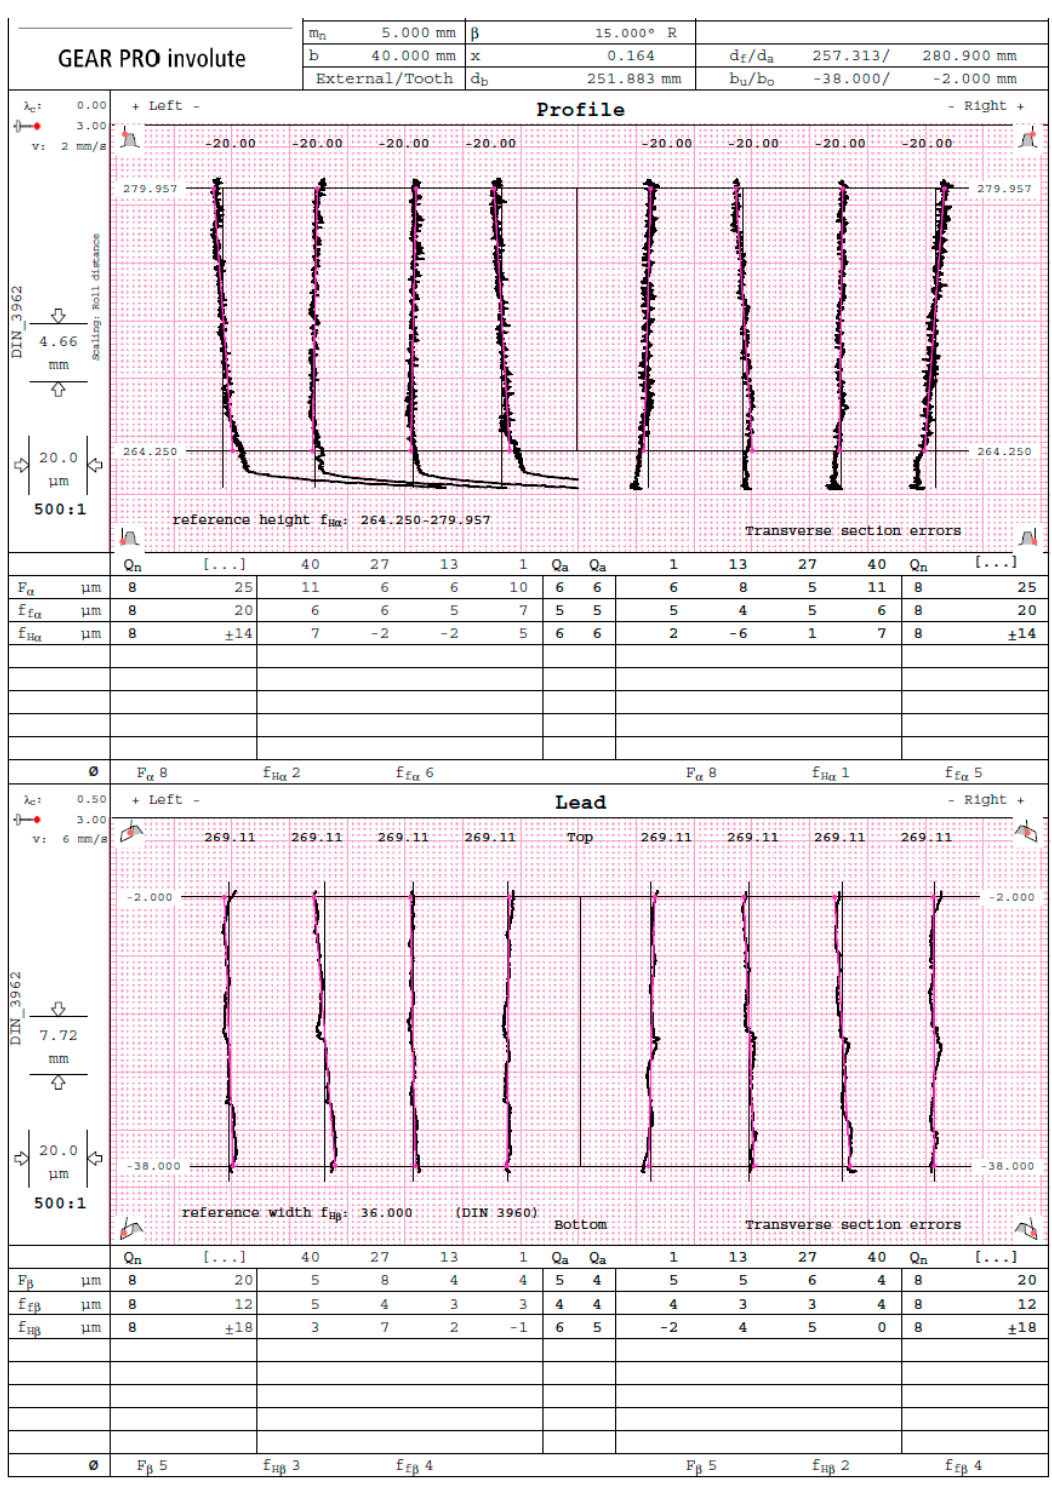
Figure 5. Gear measurement plot of manufactured soft gear, VP1.5.1.